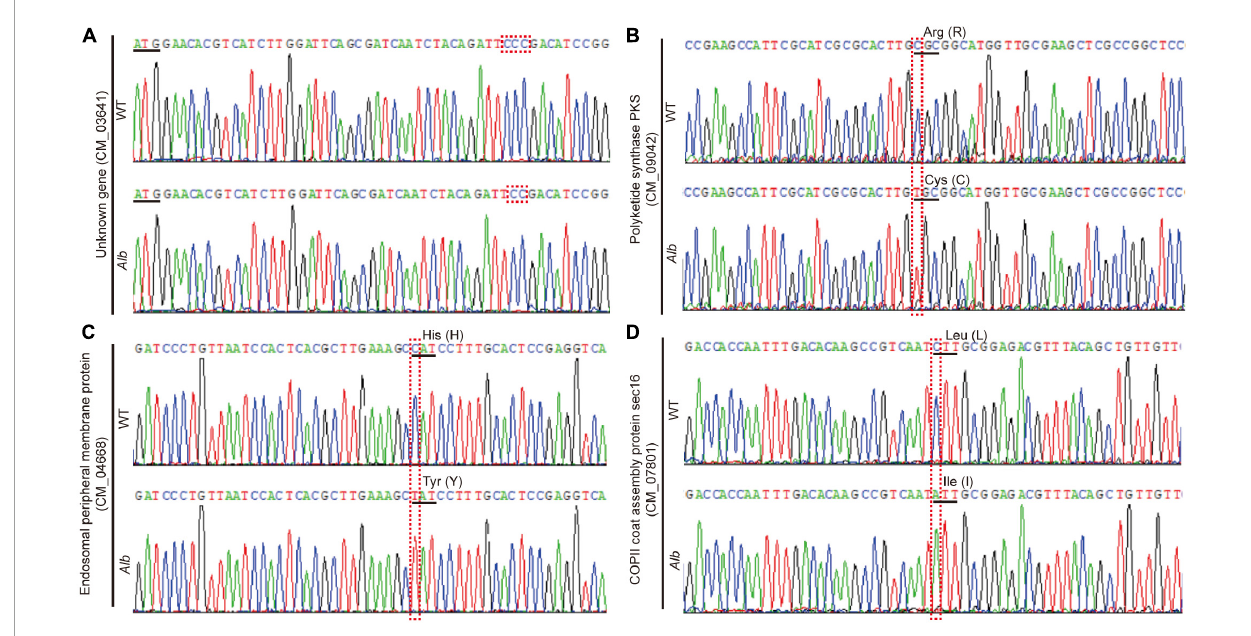
FIGURE3 Sequencing analysis of four mutation genes in WT and Alb . (A–D) Unknown gene (CM_03641), polyketide synthase (CCM_09042), endosomal peripheral membrane protein (CCM_04668), and COPII coat assembly protein sec16 (CCM_07801). WT, wild-type C. militaris ; Alb , albino mutant.